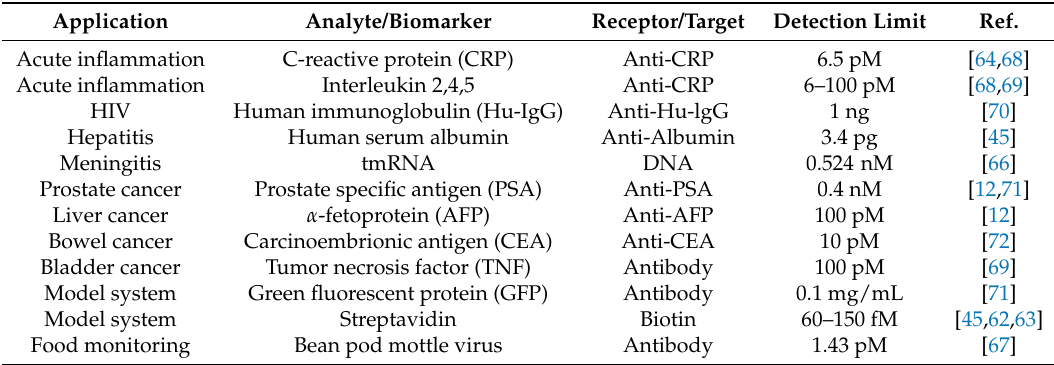
Table 2. Examples of application and selection of biomolecules that have been detected by integrated photonic biosensors based on SOI ring